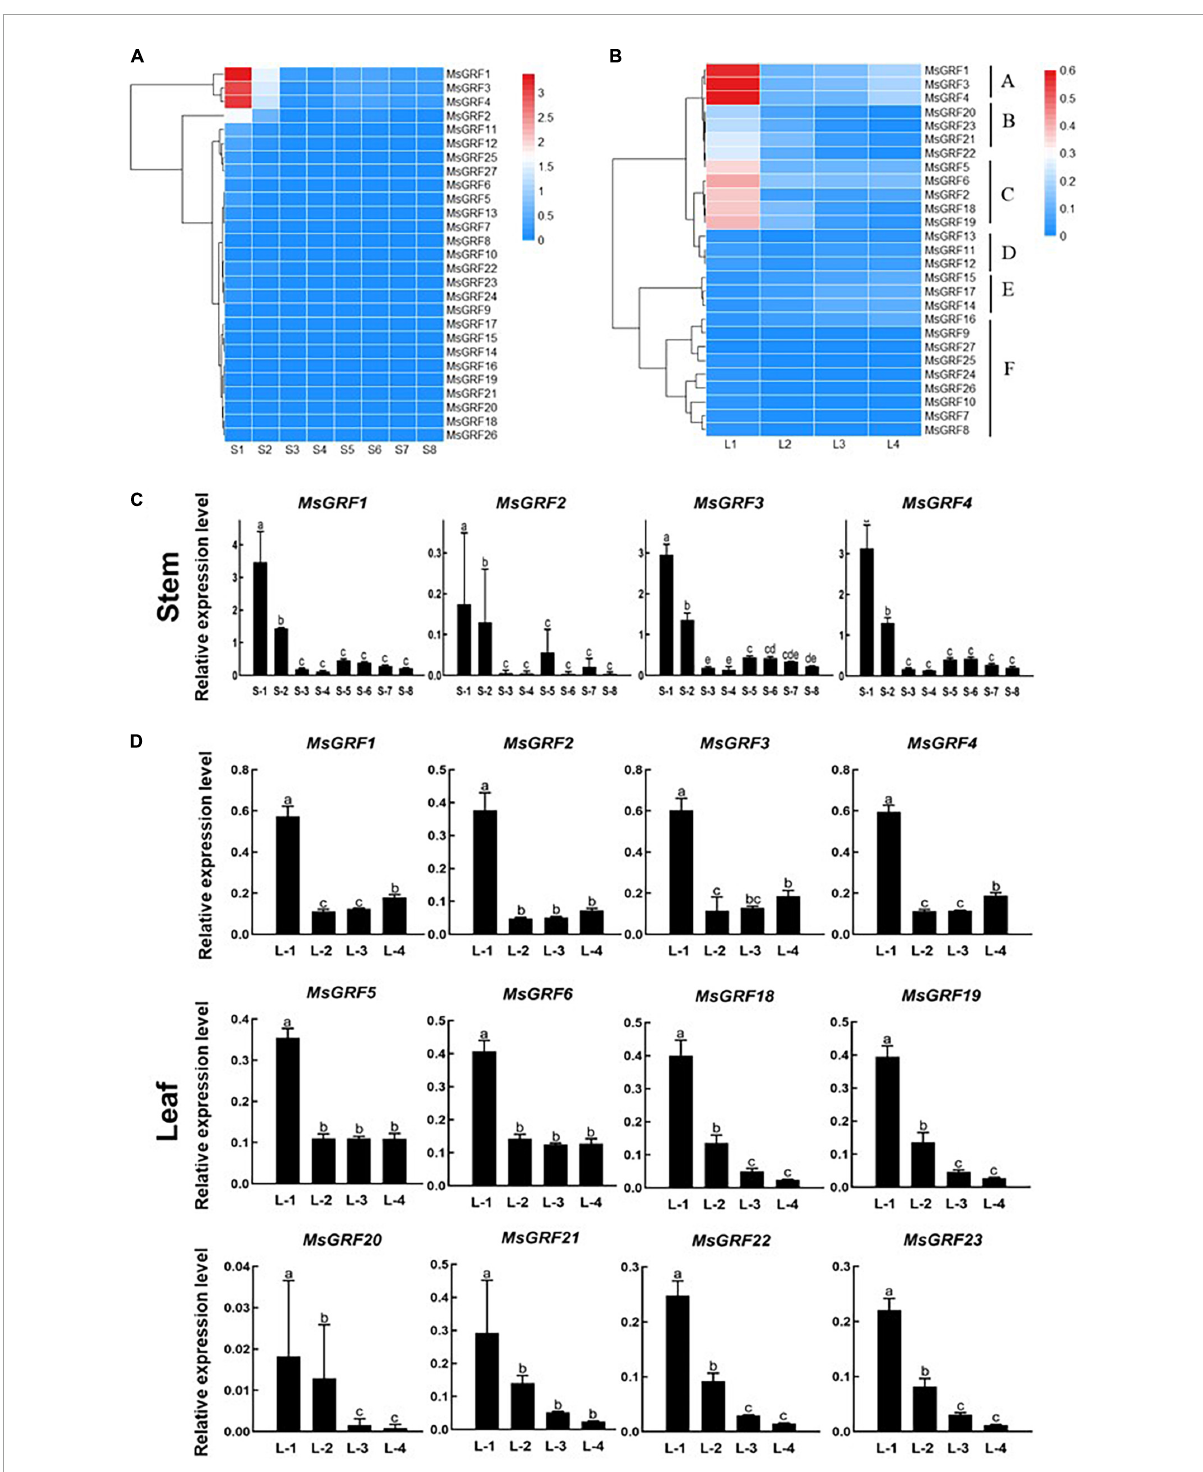
FIGURE6 Expression profiling of MsGRFs. (A) Expression profiles of MsGRFs at different developmental stages of stem internodes. Each stem internode starting from the apex is used as a developmental stage, labeled as Stem-1 to 8. (B) Expression profiles of MsGRFs at different developmental stages of leaves clustered into A to F six clades. L1 to L4 indicates the leaf development according to leaf position, and the first leaf that has not fully unfolded is regarded as the first stage of leaf development (L1). (C,D) qRT-PCR quantification of gene expression levels of selected MsGRF genes from (A,B) displayed in a column chart. The different letters (a, b, c, etc.) indicate the significant difference at P < 0.05 by Student’s t -test